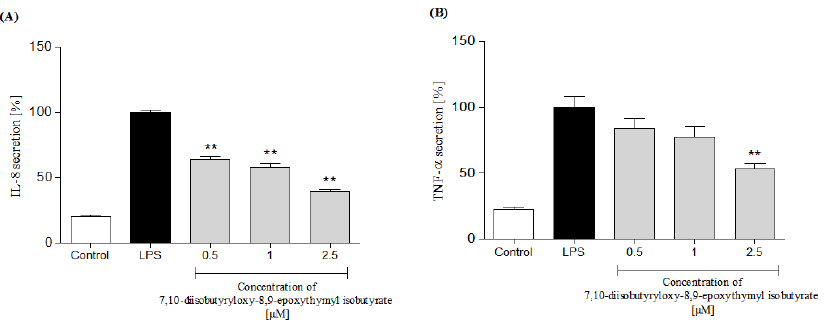
Figure 6. Inhibitory effects of 7,10-diisobutyryloxy-8,9-epoxythymyl isobutyrate, at concentrations 0.5, 1.0 and 2.5 µ M, on IL-8 ( A ) and TNF- α ; ( B ) secretion by LPS-stimulated human neutrophils. Statistical significance: ** p < 0.001, with reference to a stimulated control.